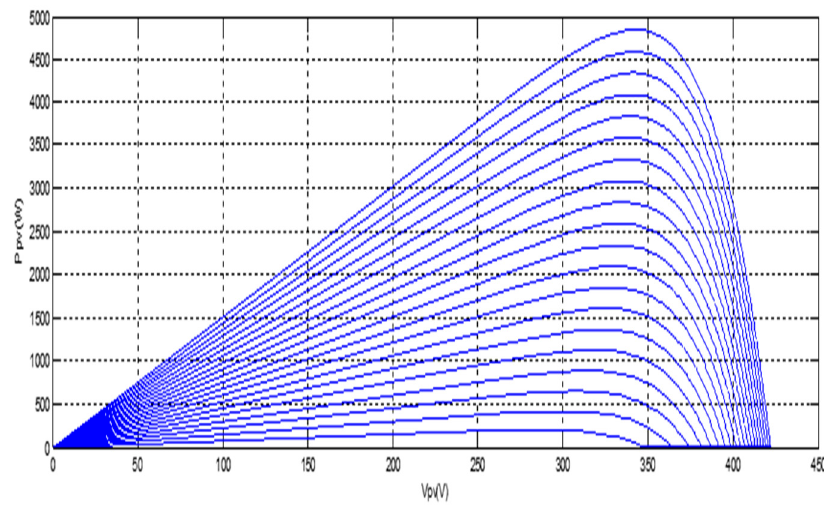
Figure 6. P-V characteristics curves.